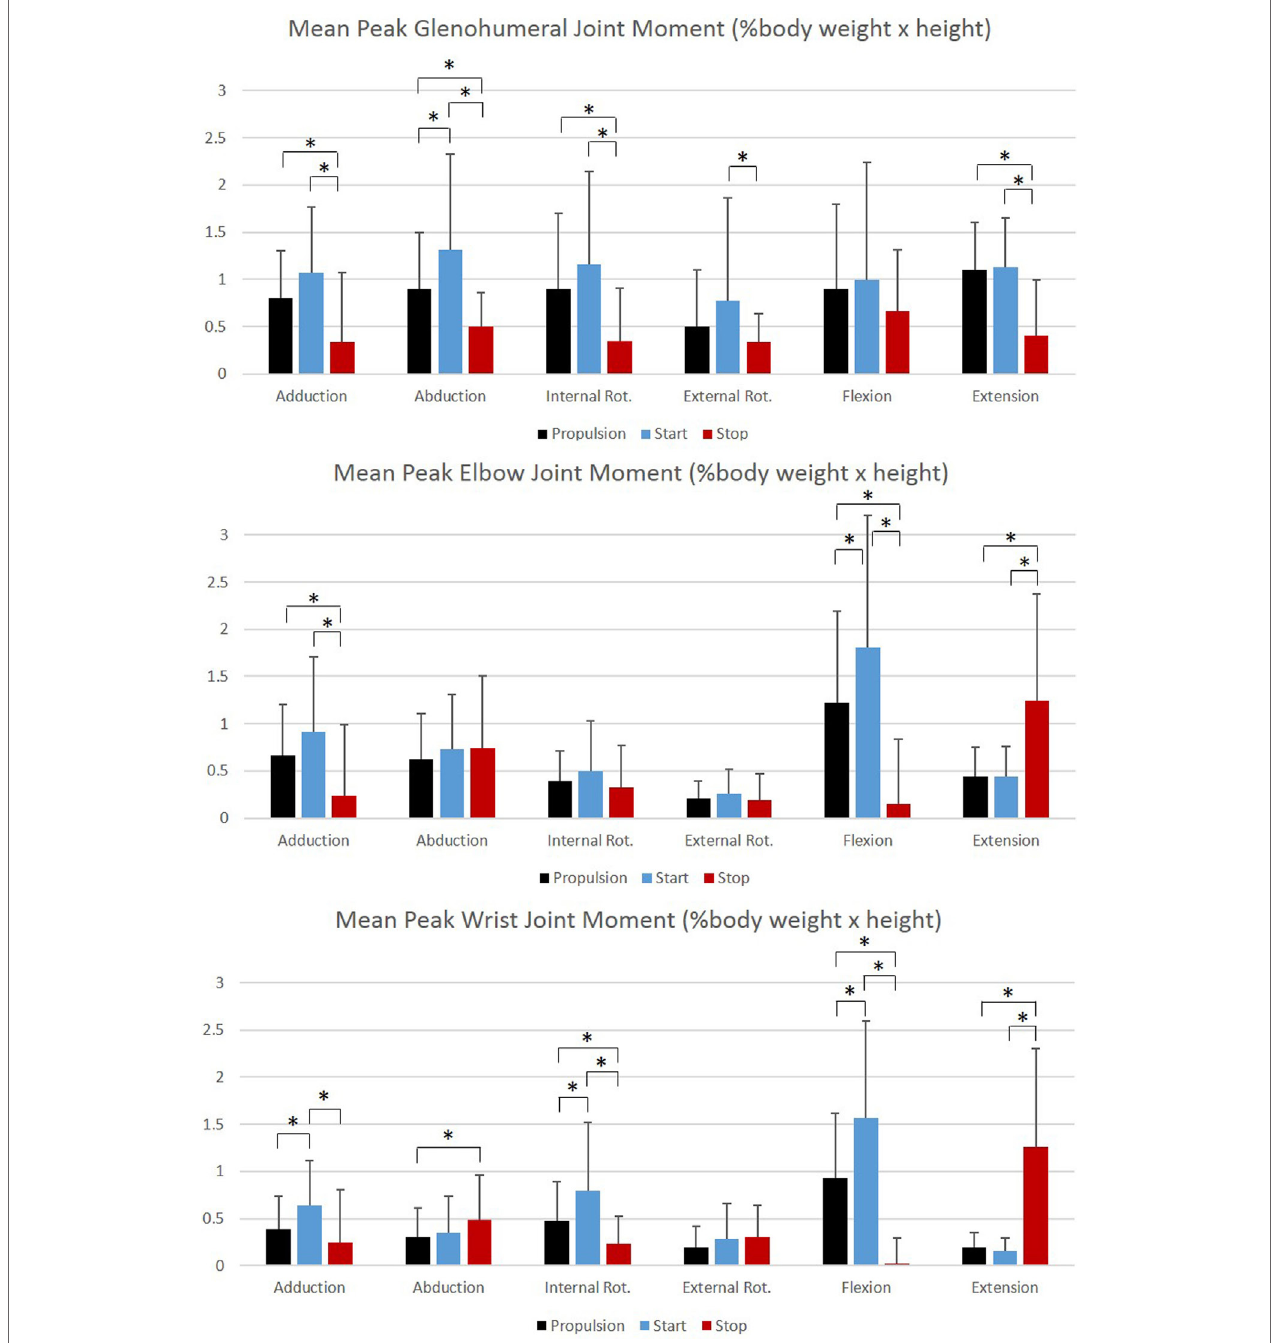
FigUre 11 | group mean peak joint moments (% BW × h) for the glenohumeral, elbow, and wrist joints during each functional mobility task, propulsion (black), start (blue), and stop (red) . One SD is represented by the thin vertical bar. Tasks connected by an asterisk are statistically significantly different ( p <